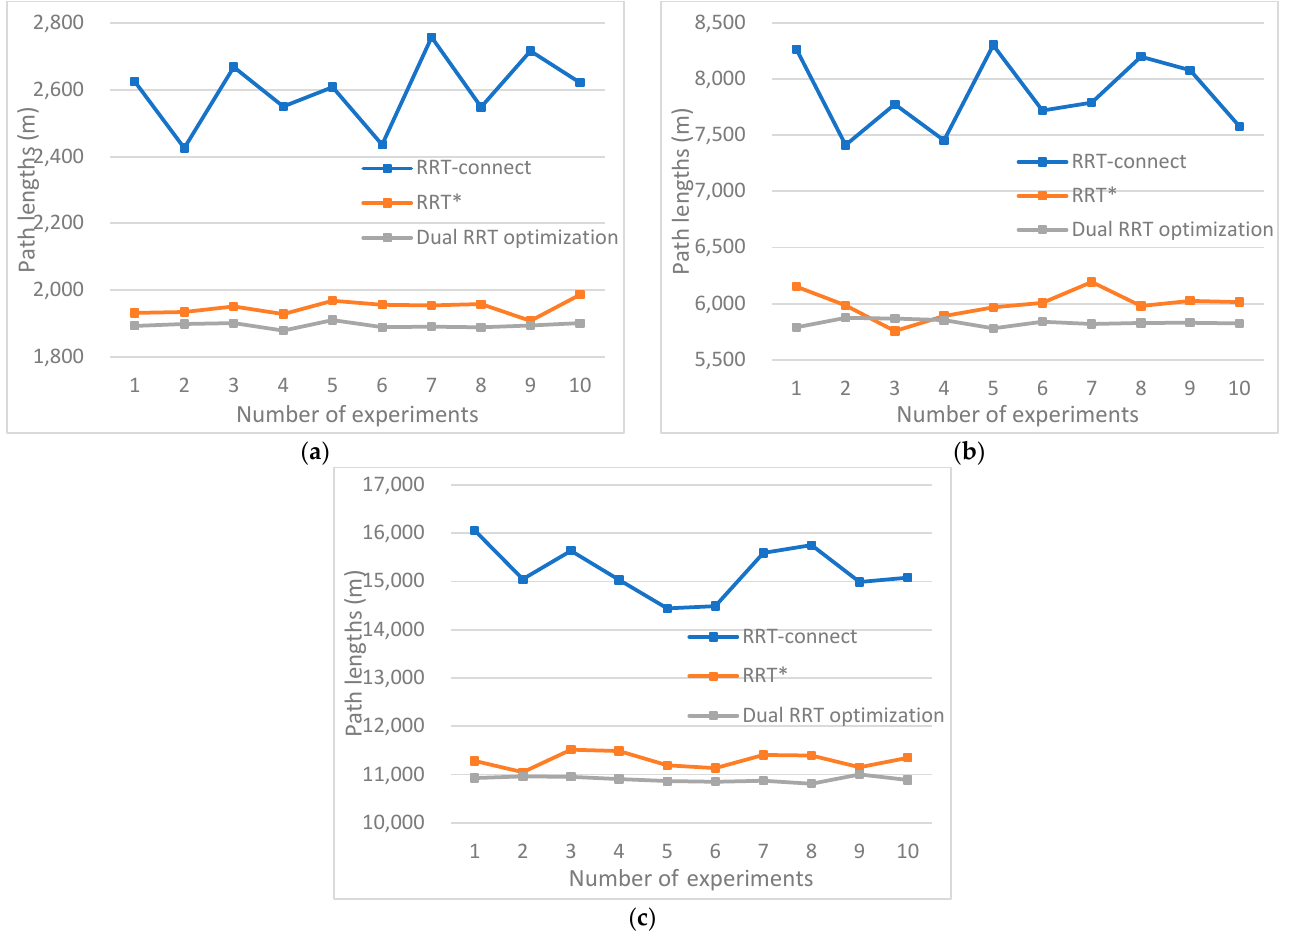
Table 2. Experimental environmental parameters under obstacle maps.